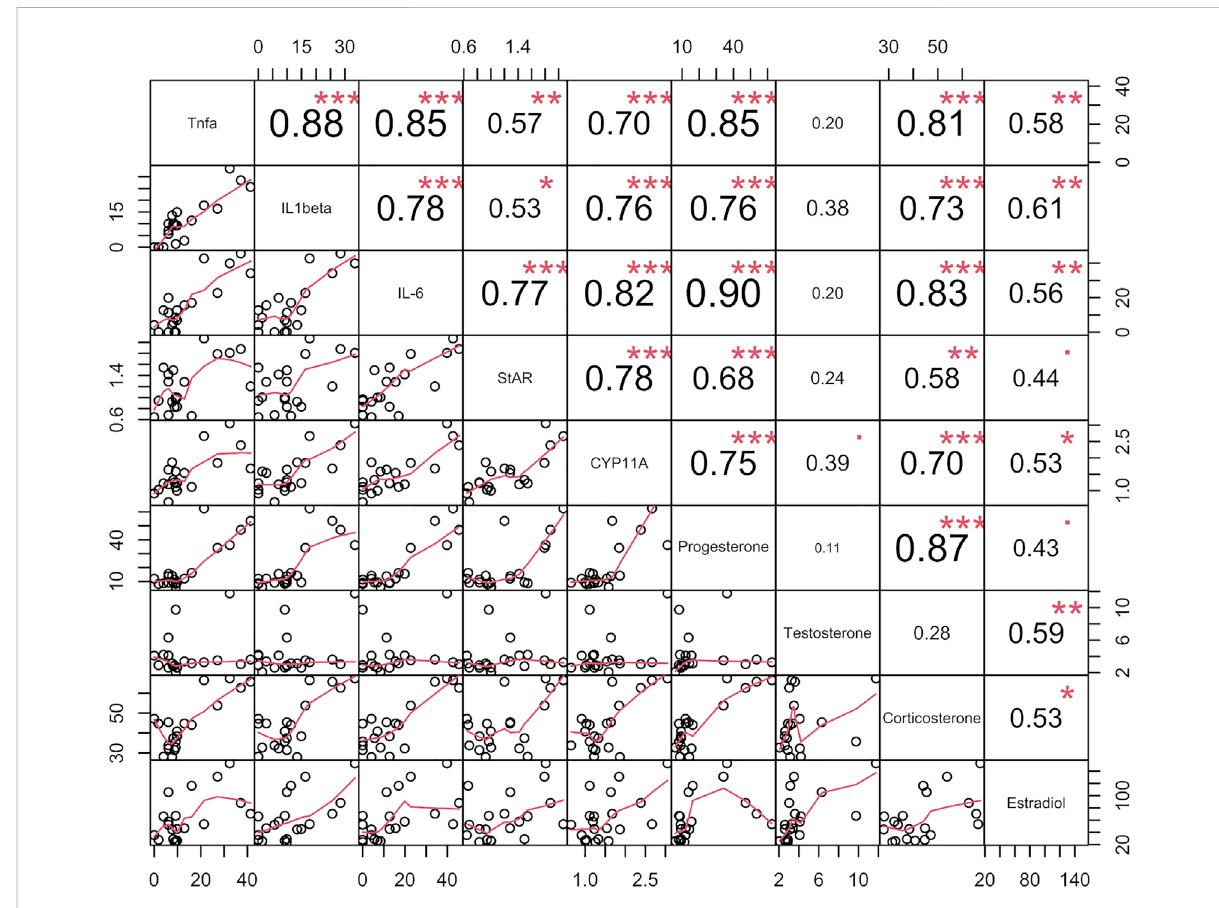
FIGURE 9 Correlation analysis of four sex steroids (progesterone, testosterone, estradiol and corticosterone), three in fl mmatory cytokins (TNF- α , IL-6, and IL-1 β ) concentrations in serums, and the two sex hormone synthesis gene expression in ovories in veri fi cation experiment. The data name appears on the primary diagonal line. Data for each type is an aggregate of data of rats in all groups, including normal group (6, N), normal with AG administration group (6, AG 40 mg/kg, NAG), model group (6, LPS 100 μ g/kg, M) and high dose (6, LPS 100 μ g/kg + AG 40 mg/kg, AG) groups. The circles in the sub-boxes below the main diagonal indicate pairs of two kinds data of the same rat, and the red line depicts the correlation trend. The correlation coef fi cient is indicated in each box above the main